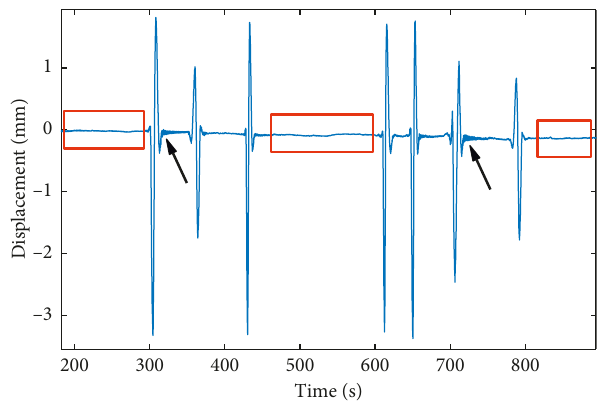
Figure 10: Data input for time-series-based damage detection algorithm (searching for stationary signals using selected param- eters of object